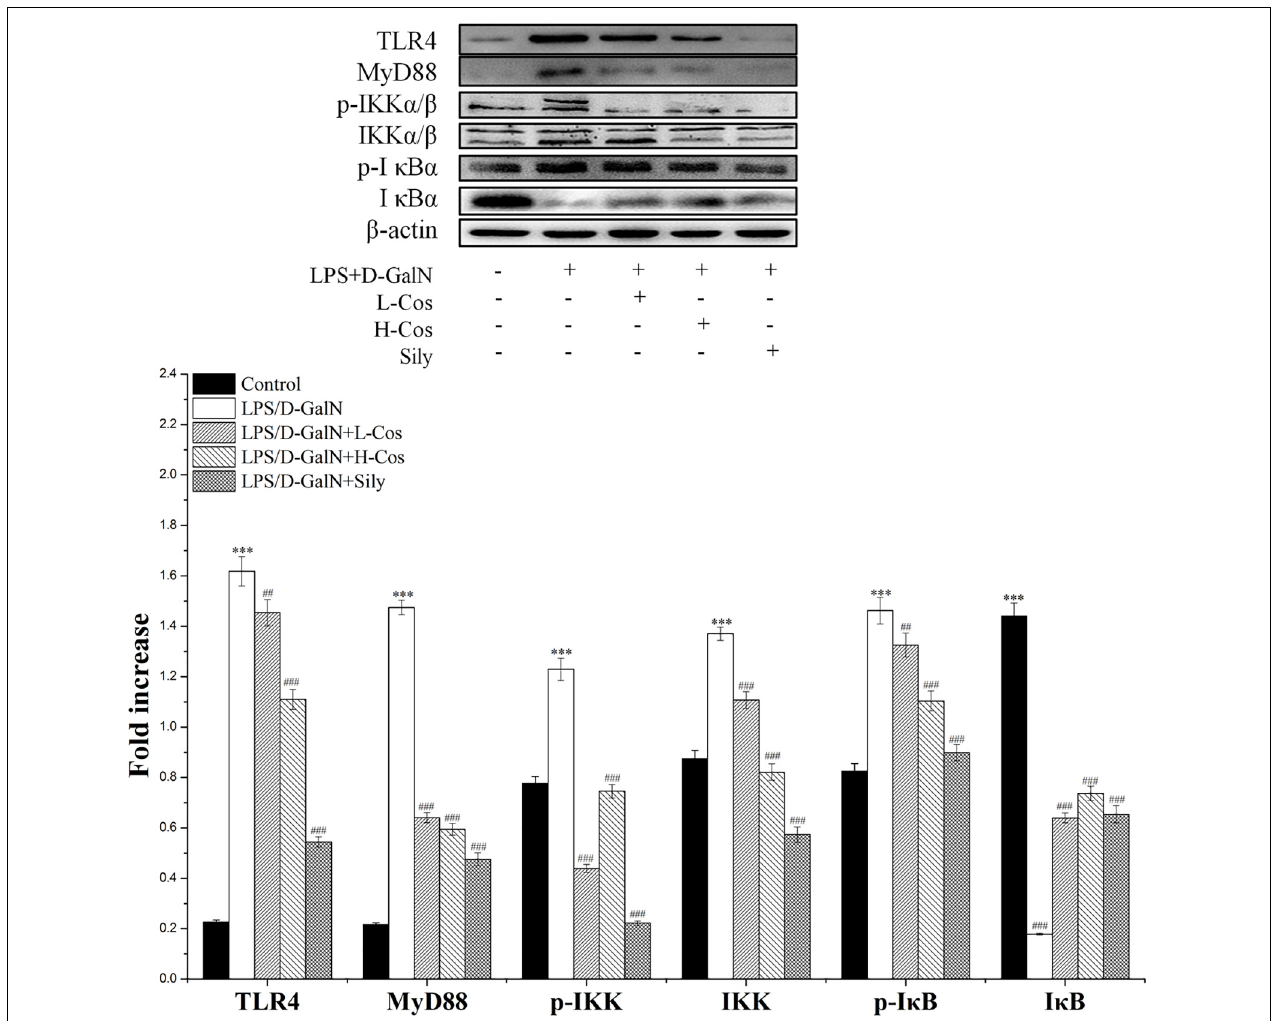
FIGURE 6 | Effects of cos on the expression of NF- κ B-MyD88 signaling pathway. Western blot analysis of the TLR4, MyD88, IKK, p-IKK, I κ B, and p-I κ B proteins. The density values of the western blot were normalized for β -actin. ∗∗∗ P < 0.01 vs. control group; ## P < 0.01 and ### P < 0.0001 vs. LPS/ D -GalN